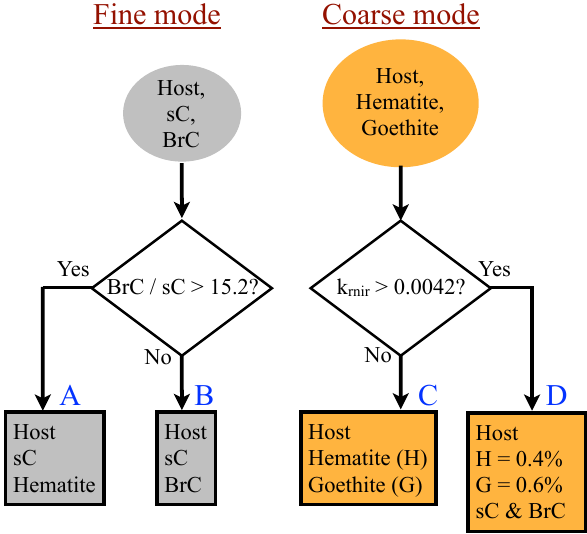
Figure 6. Flowchart showing absorbing aerosol retrieval process. Initially, all carbonaceous species are assumed to occupy the fine mode and all iron oxide (hematite, goethite) is assumed to occupy the coarse mode. If BrC / sC > 15 . 2 would be required for a two- component mixture, then hematite is used instead of BrC to char- acterize the spectral dependence of the refractive index in the fine mode (branch A). Likewise, if the retrieved absorption at the red and near-infrared wavelengths is above a threshold of k rnir = 0 . 0042, then the hematite and goethite fractions are fixed at the values we retrieved for “pure” African dust, and some carbonaceous aerosol is assumed to occupy the coarse mode (branch D).